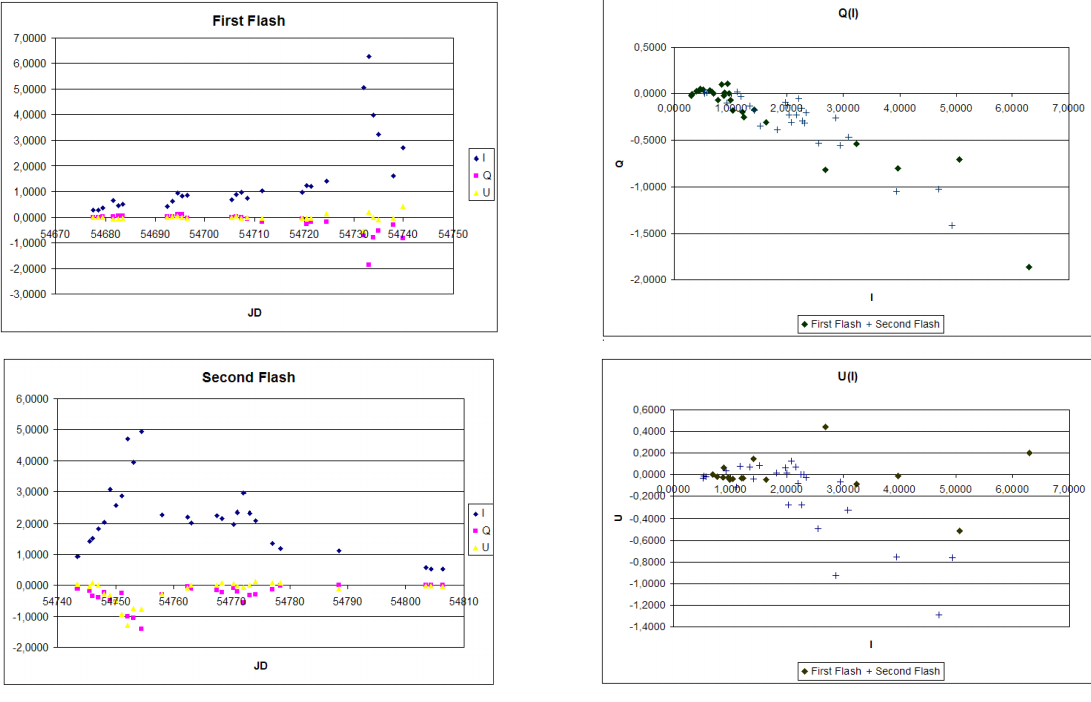
Figure 8. Absolute Stokes parameters behaviour at different flashes ( left ) and Q ( I ) and U ( I ) ( right ) at the second